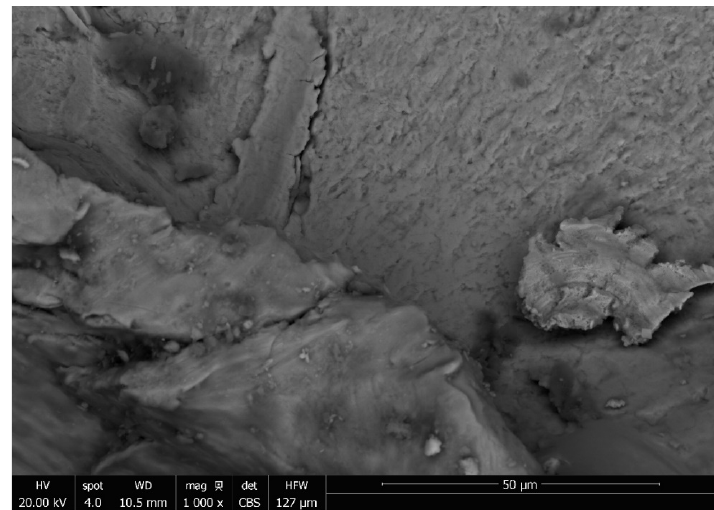
Figure 13. Topographical SEM image of the fracture initiation area.